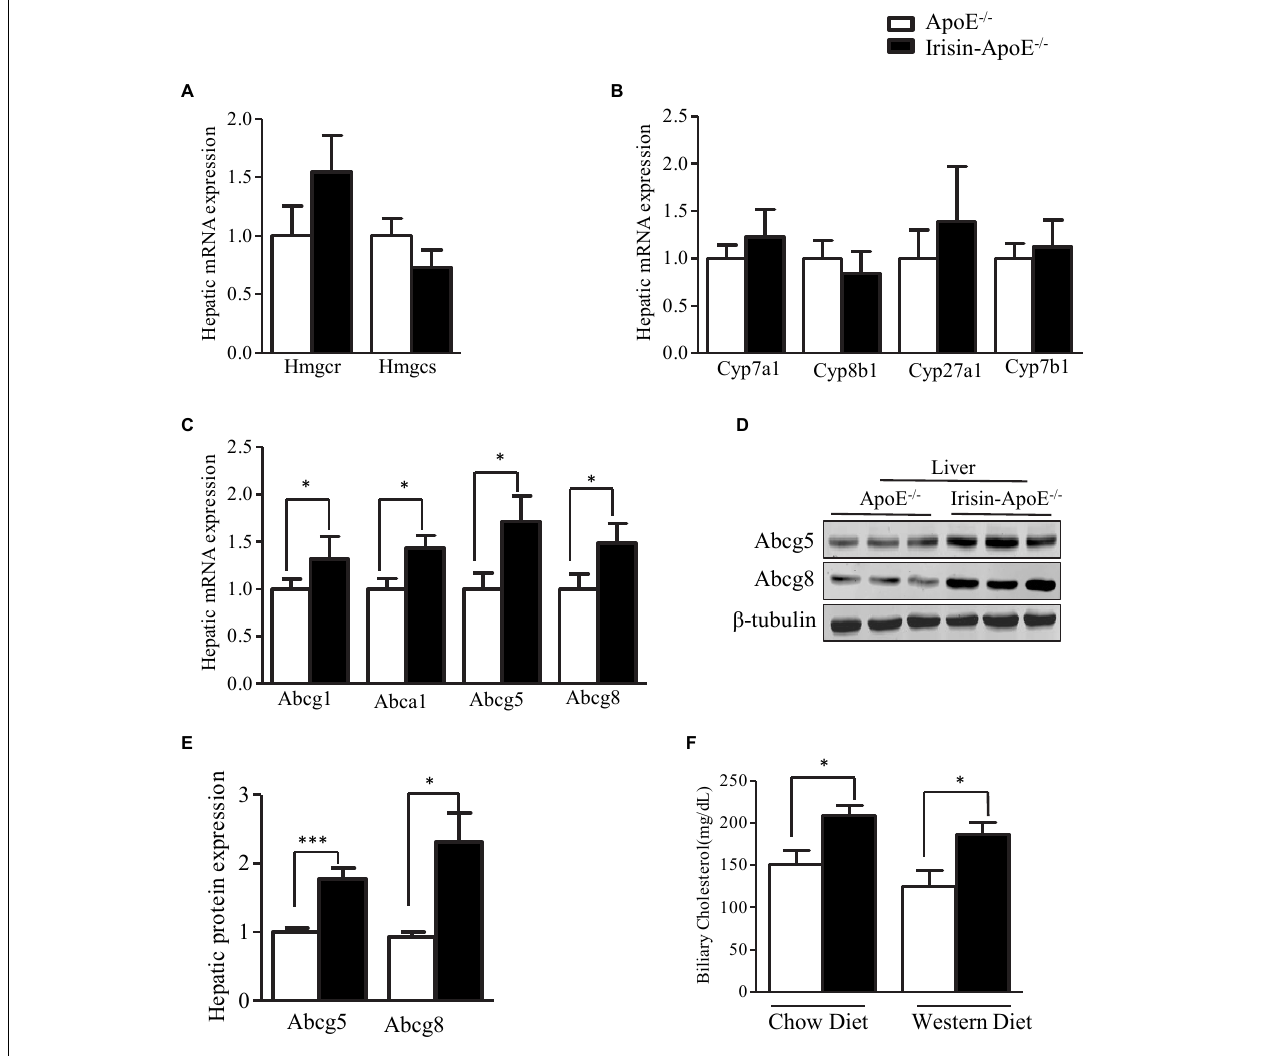
FIGURE 4 | Irisin increases hepatic expression of Abcg5 and Abcg8 in ApoE − / − mice. (A,B) Real-time PCR analysis of hepatic mRNA expression of cholesterol and bile acid synthesis genes ( n = 8). (C) mRNA expression of hepatic cholesterol transporters ( n = 6). (D,E) Protein levels of hepatic Abcg5 and Abcg8 in mice ( n = 3). (F) Biliary cholesterol level in mice ( n = 5). Data are means ± SEM. ∗ P < 0.05; ∗∗∗ P <